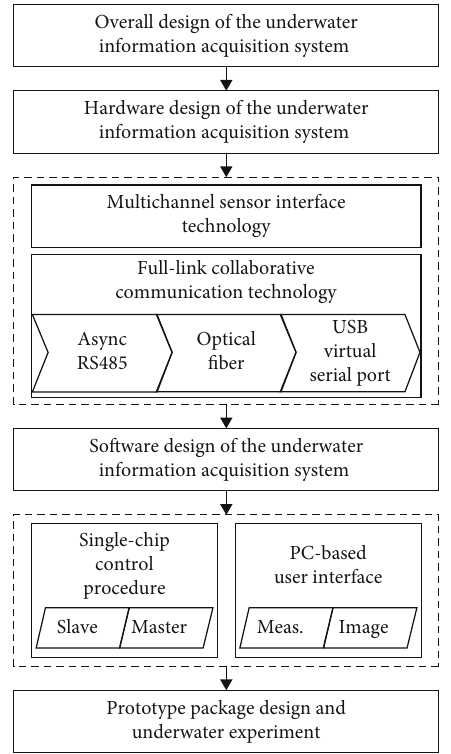
Figure 1: Prototype implementation.